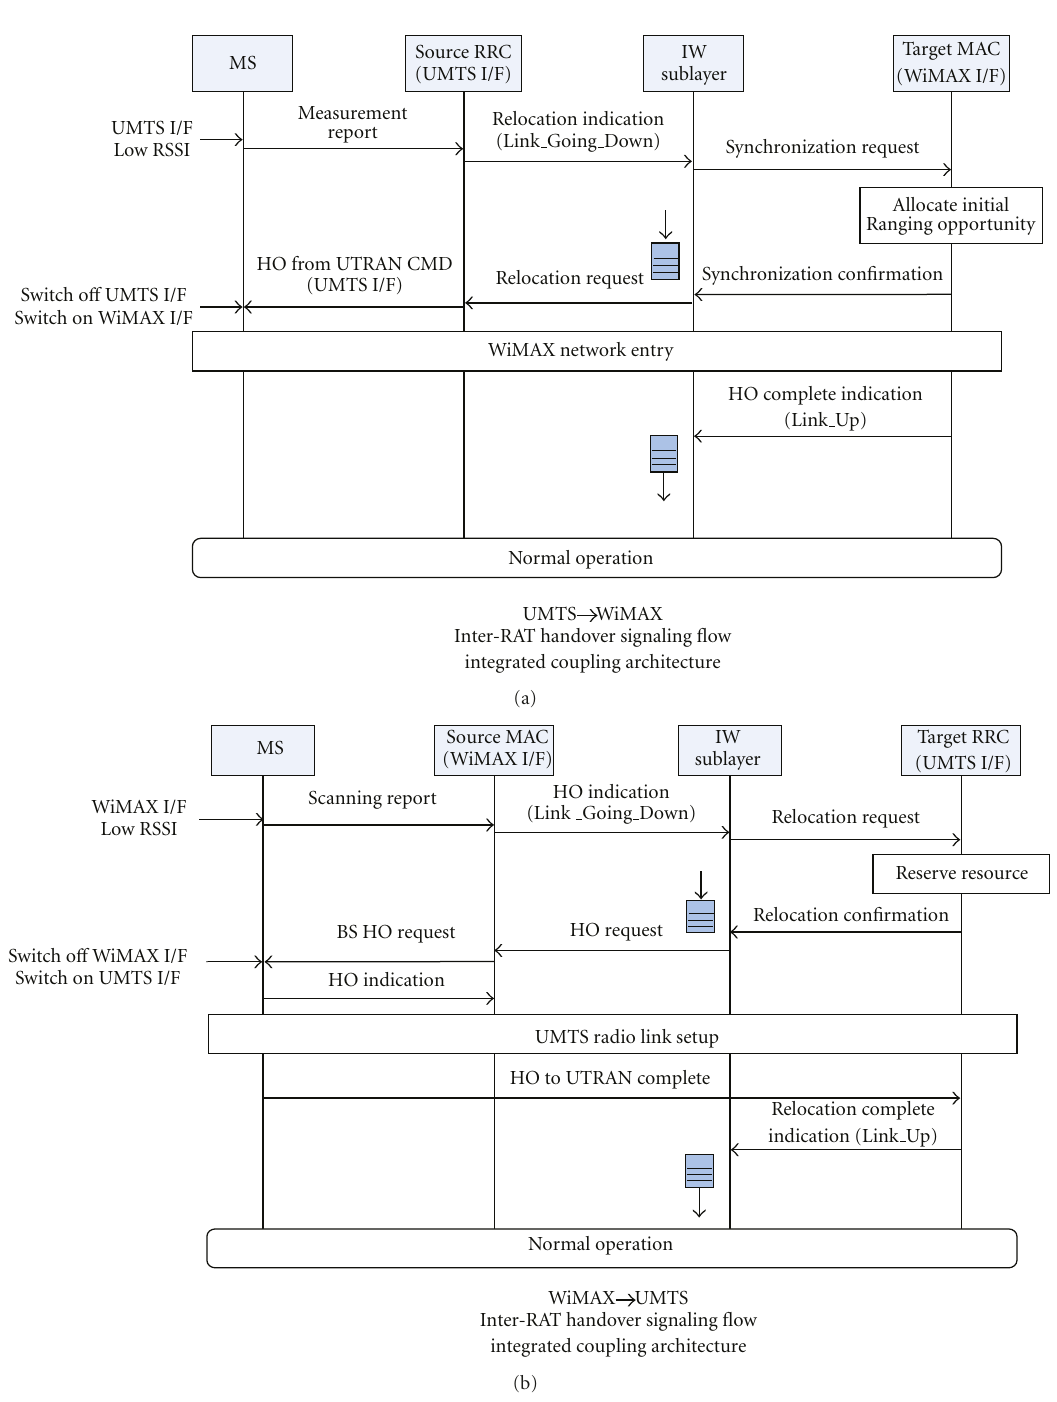
Figure 5: Inter-RAT handover signaling procedures: (a) UMTS → WiMAX; (b) WiMAX → UMTS.